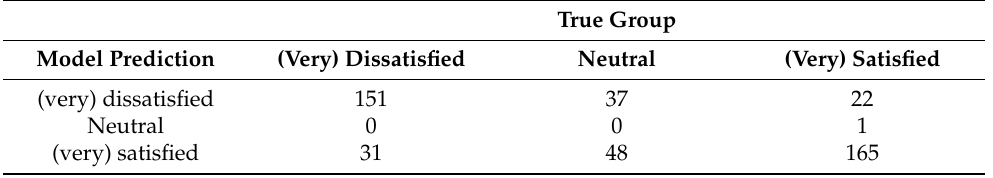
Table 3. Confusion matrix showing the results of the model accuracy in the test sample ( n = 455).